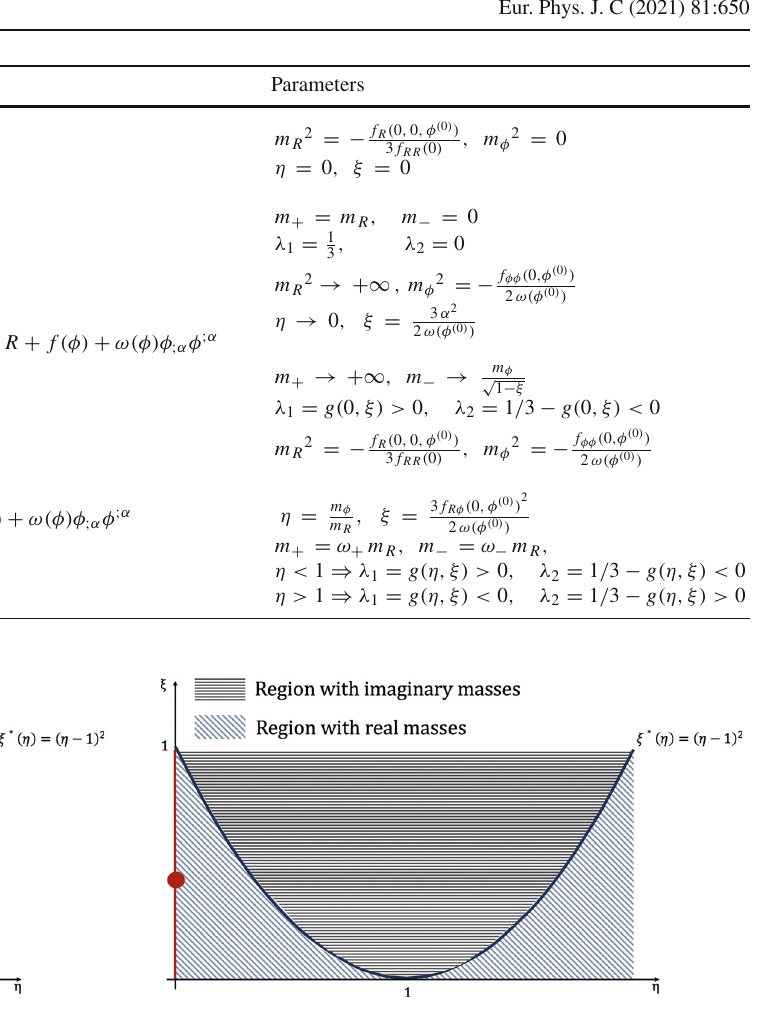
Fig. 3 Models with the following structure R + α φ R + f (φ) + ω(φ)φ ; α φ ; α can be represented in η ξ − plan as a point of the segment (in red): (η,ξ) ≡ ( 0 ,ξ) , with 0 < ξ <